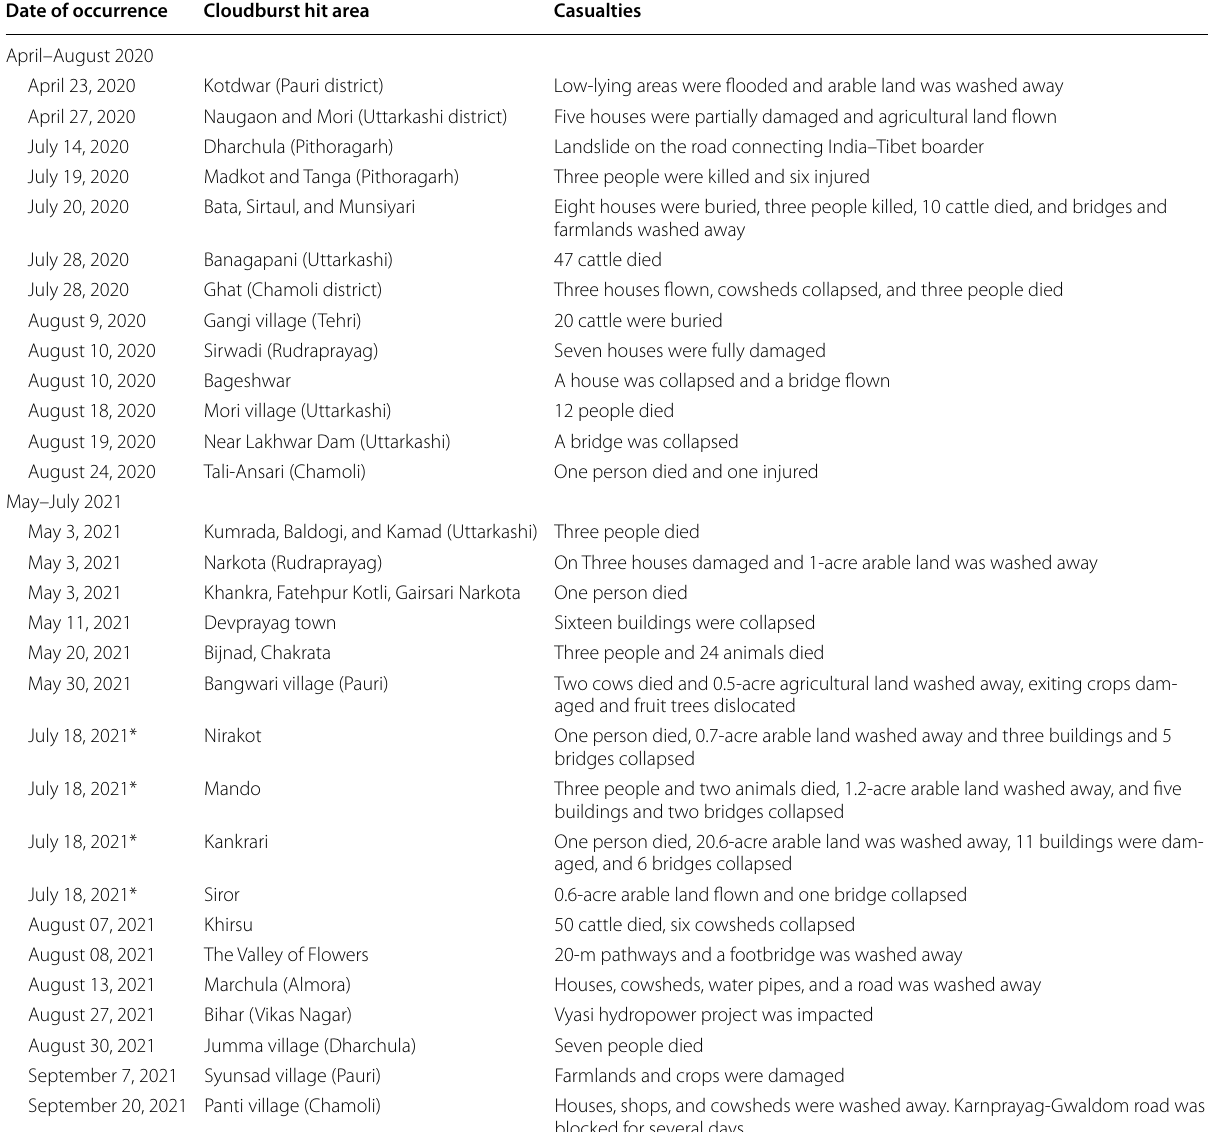
Table 1 Major cloudbursts occurred in Uttarakhand in 2020 and 2021. Source: SDRF